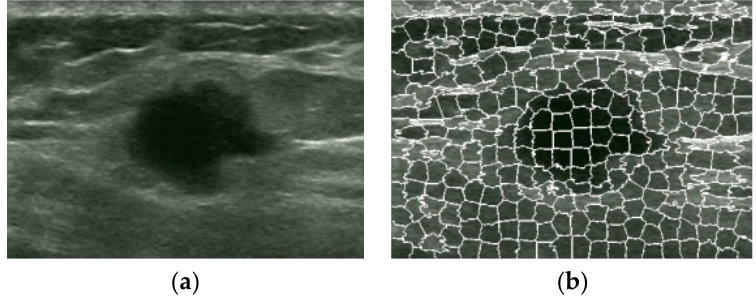
Figure 6. Superpixel image obtained by SLIC: ( a ) Original image. ( b ) Superpixel image .